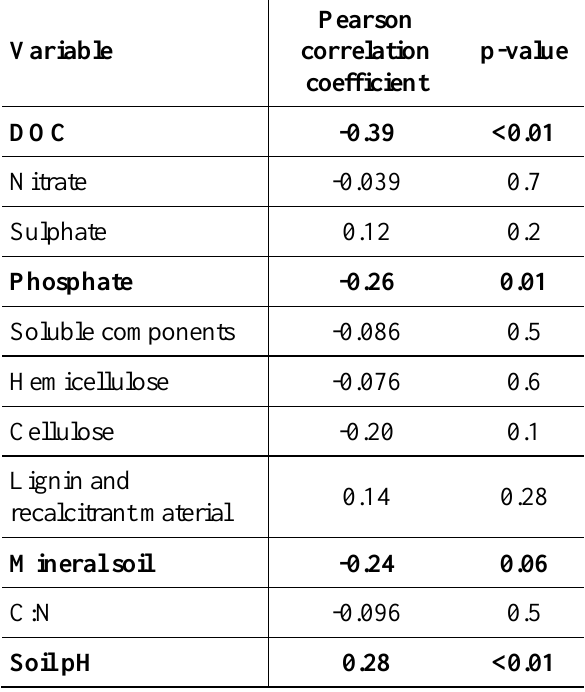
Table 3. Correlations of carbon dioxide (CO ) fluxes 2 with biochemical parameters across the shallow cores from all sites. Values in bold indicate a significant correlation with CO 2